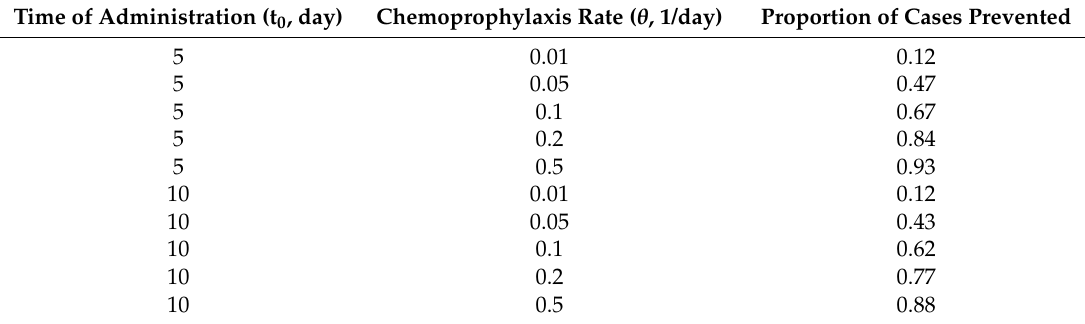
Time of Administration (t 0 ,